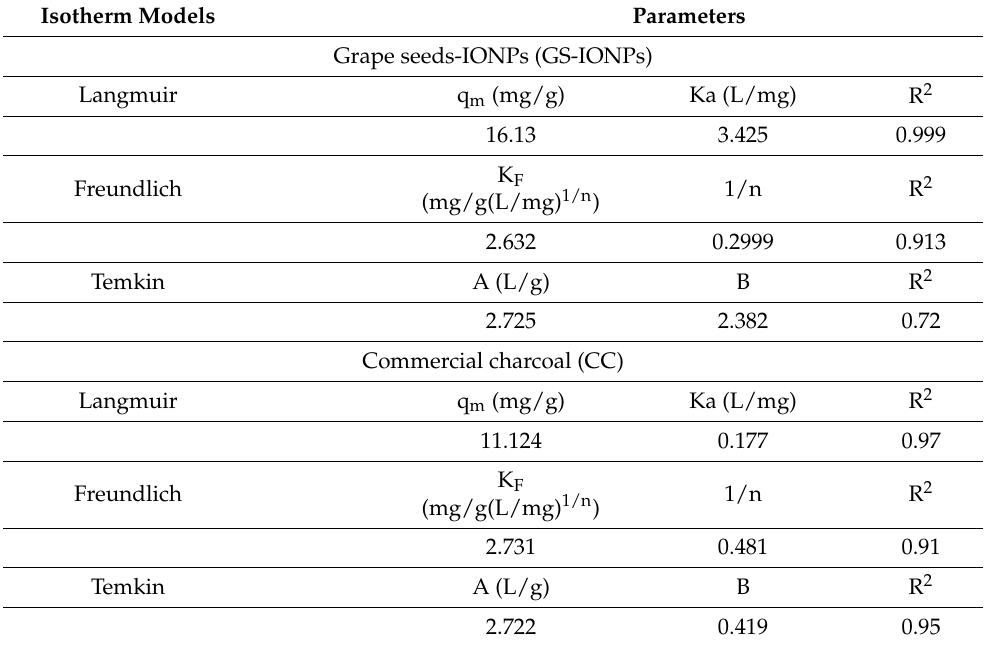
Table 3. Langmuir, Freundlich and Temkin isotherm models parameters and correlation factors for the adsorption of cadmium onto GS-IONPs and commercial charcoal at 30 ◦ C. Isotherm Models Parameters Grape seeds-IONPs